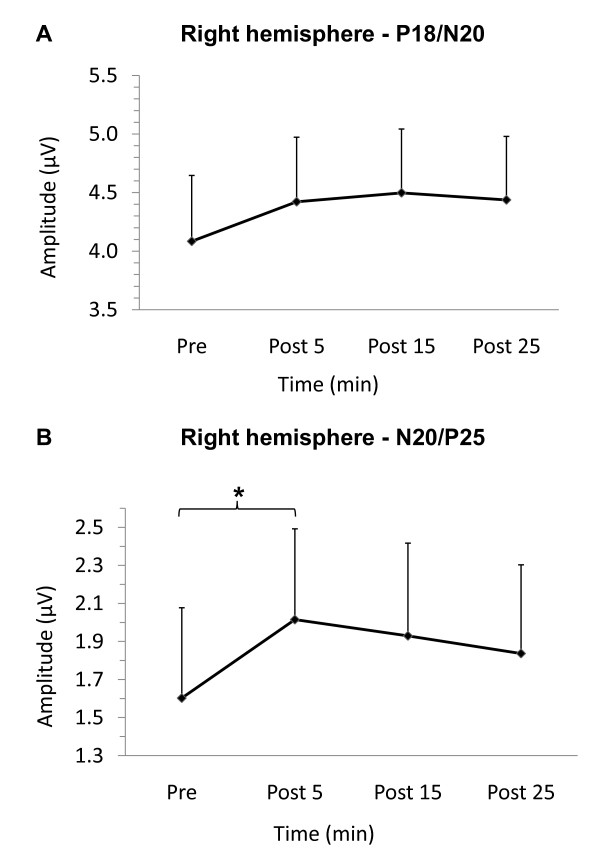
Right-hemiphere SEPs. Group averaged SEPs recorded from right-hemisphere, non-stimulated SI. A. P18/N20 peak-to-peak group averaged data (n = 11) pre and post-iTBS. B. N20/P25 peak-to-peak group averaged data (n = 11) pre and post-iTBS. SEP amplitude is significantly greater at 5 min following iTBS only (p < 0.017, Bonferroni correction for 3 comparisons). Error bars represent standard error of the mean.